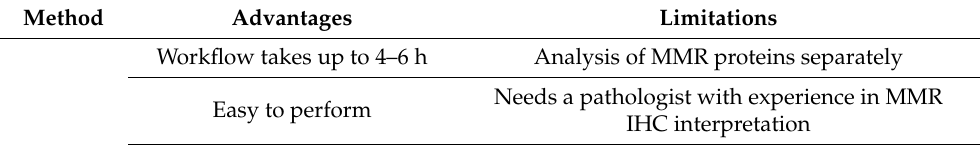
Table 1. Tissue-based methods for MSI screening to distinguish sporadic tumours from lynch